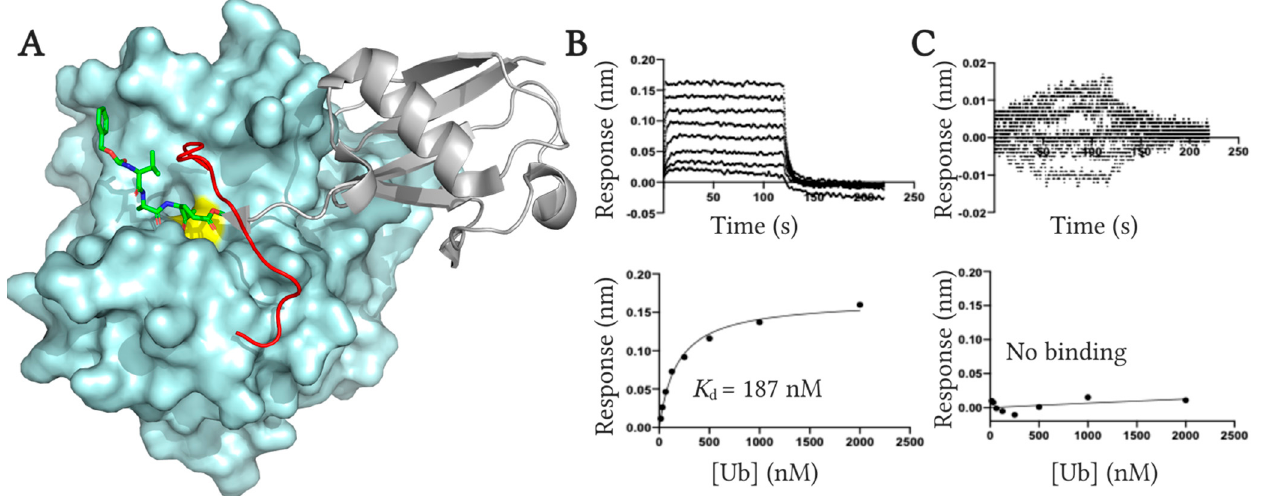
Figure 6. Competition of binding for 1 versus Ub. ( A ) Overlaid crystal structure of 1 (green sticks) bound to UCHL1 (cyan surface) (PDB: 4DM9) and Ub (gray ribbon) bound to UCHL1 (PDB: 3KW5). Crossover loop of UCHL1 shown in red ribbon for clarity. ( B ) Association/dissociation and steady-state binding data for UCHL1 and 1:1 serial dilutions Ub in BLI assay buffer. ( C ) Association/dissociation and steady-state binding data for UCHL1 after preincubation with 1 .